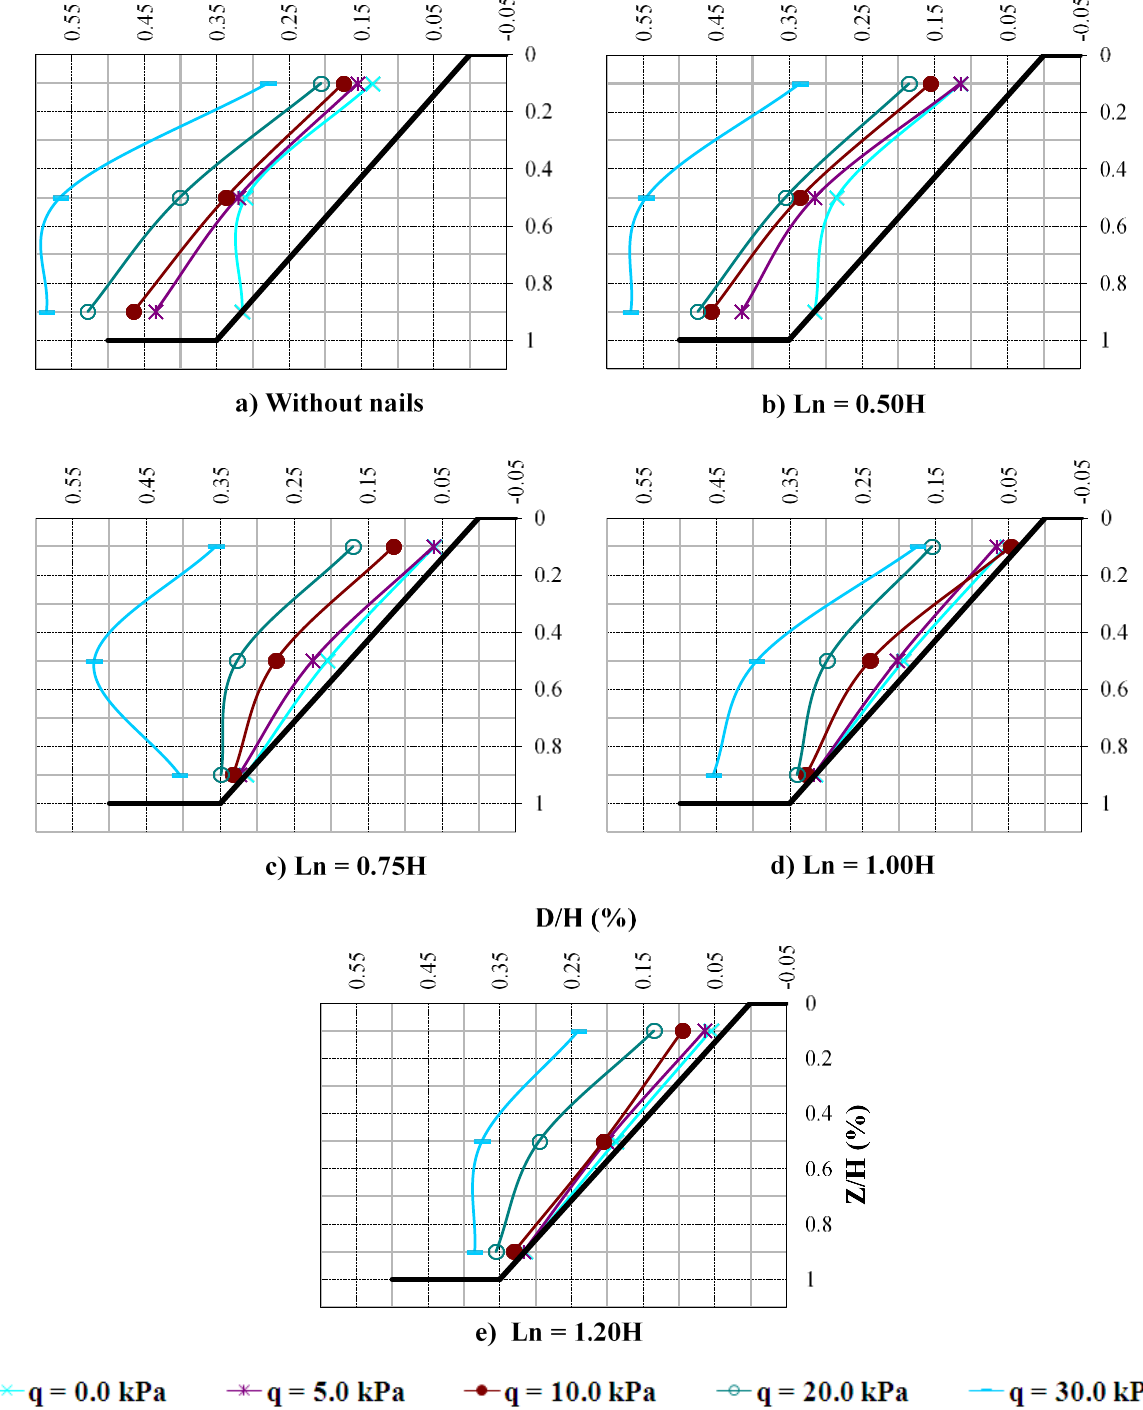
Figure 5. Lateral movement of the slope at different nail lengths.